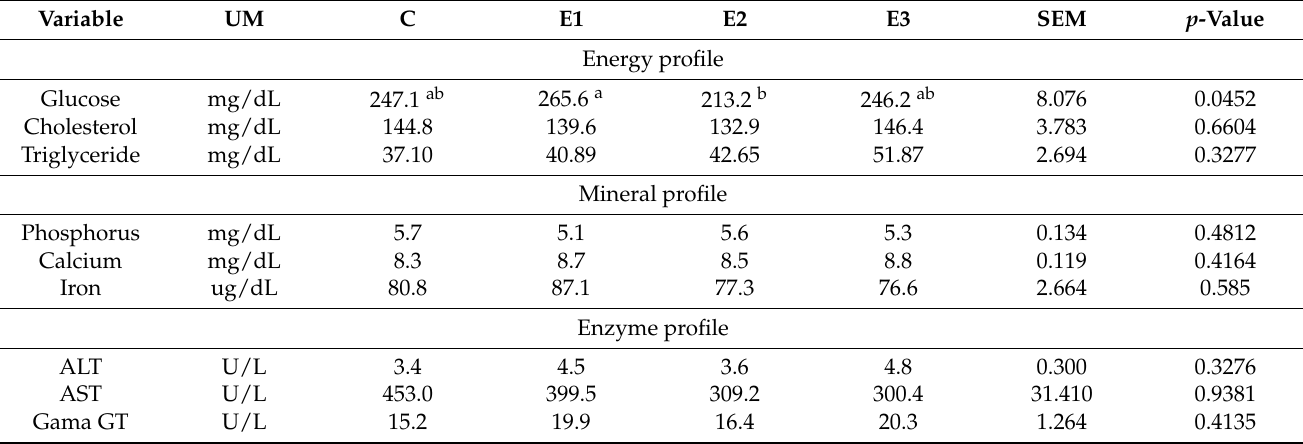
Table 2. Biochemical parameters determined in blood serum samples.